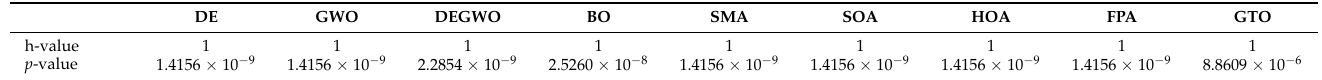
Table 4. Comparison under Wilcoxon rank-sum test on test case 1.